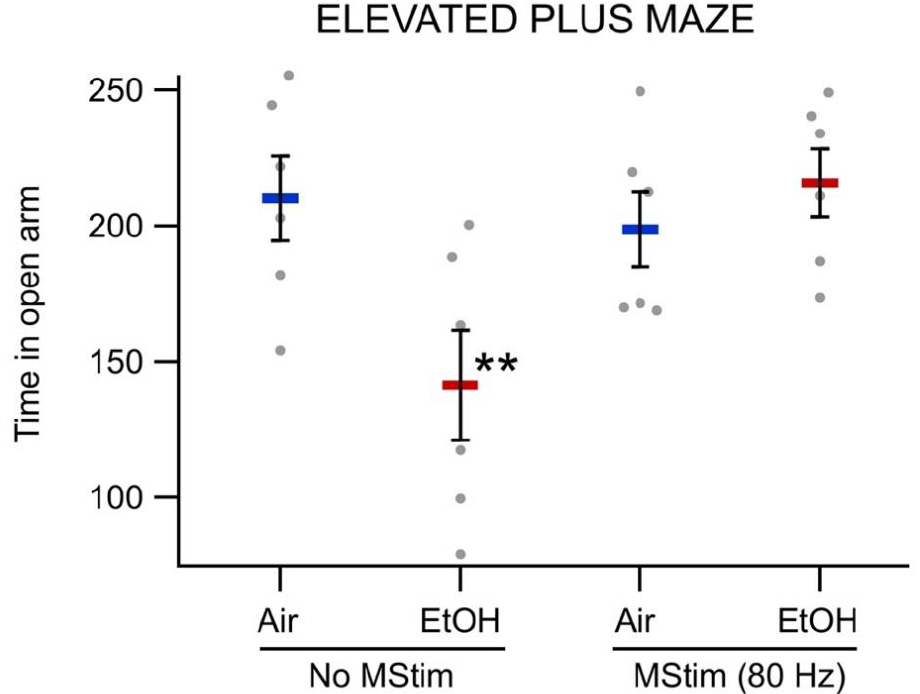
Figure 5. Effects of MStim on Elevated Plus Maze scores. Twenty-four hours following final EtOH or air exposure, animals were placed in Elevated Plus Maze assay and the time spent in the open arm was recorded. Mechanical stimulation significantly increased the time spent in the open arm when compared to EtOH alone. Asterisks (**) indicate significance level p < 0.01.